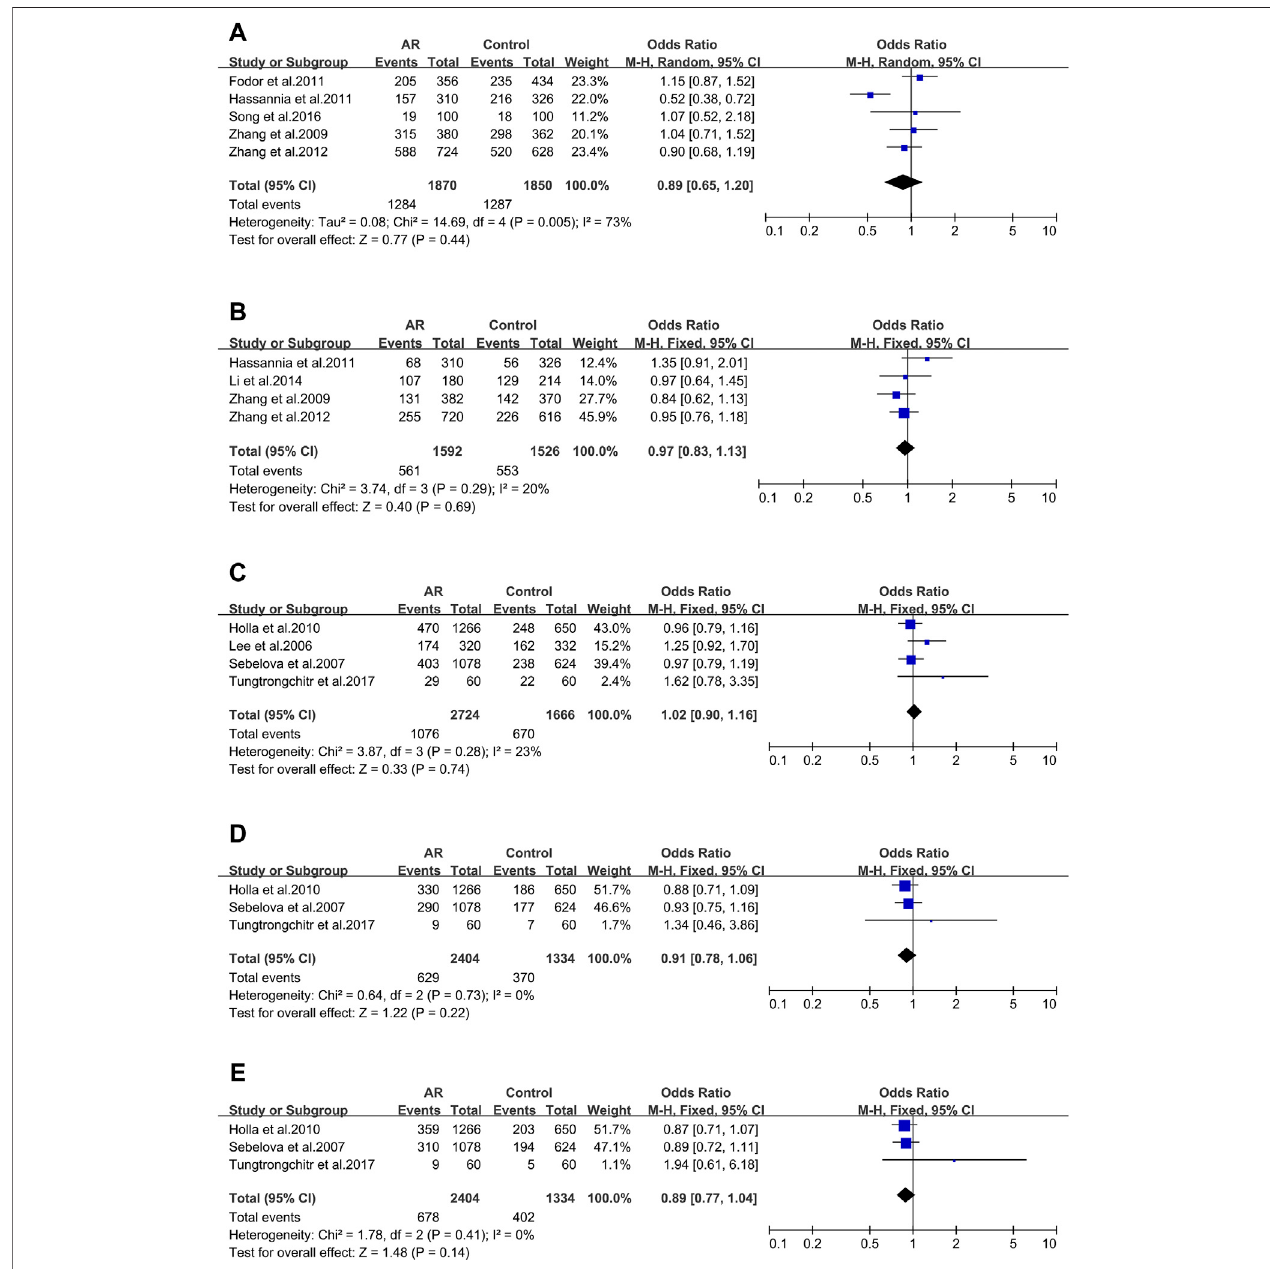
FIGURE5| ForestplotsforFOXP3andIL-18polymorphisms. (A) FOXP3(rs3761548):Callele; (B) FOXP3(rs2232365):Callele; (C) IL-18rs1946518):alleleA; (D) IL-18 (rs187238): allele C; (E) IL-18 (rs4988359): allele G.